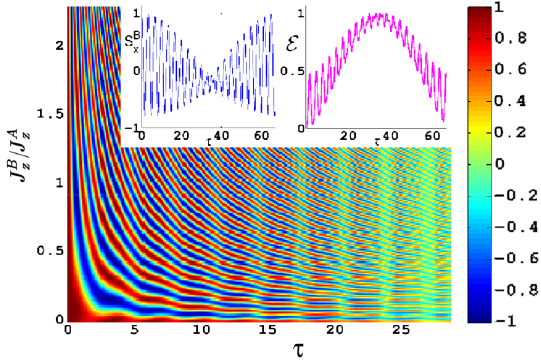
FIG. 5 (color online). Precession of qubit B starting at S B x ¼ 1 in the geometry of Fig. 1(d). Qubit A is driven at its level splitting J A ϵ ¼ 0 . 3 J A B is coupled to A z with a Rabi frequency z , and qubit with a coupling constant J AB ¼ 0 . 05 J A z . Time τ is in periods of the free precession of A . Color in the main panel and left inset: S B ð τ Þ . Right inset: Entanglement E ð τ Þ for J B ¼ 0 . 3 J A x z z . See text for